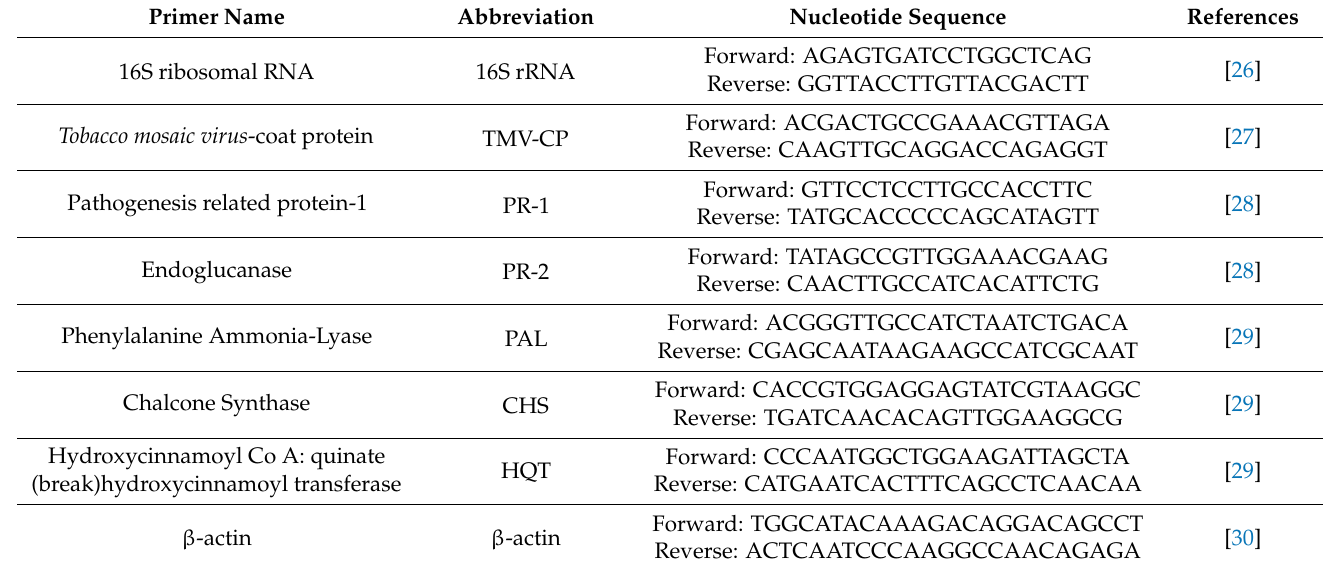
Table 1. List of the specific primer sequences of the different genes used in qRT PCR